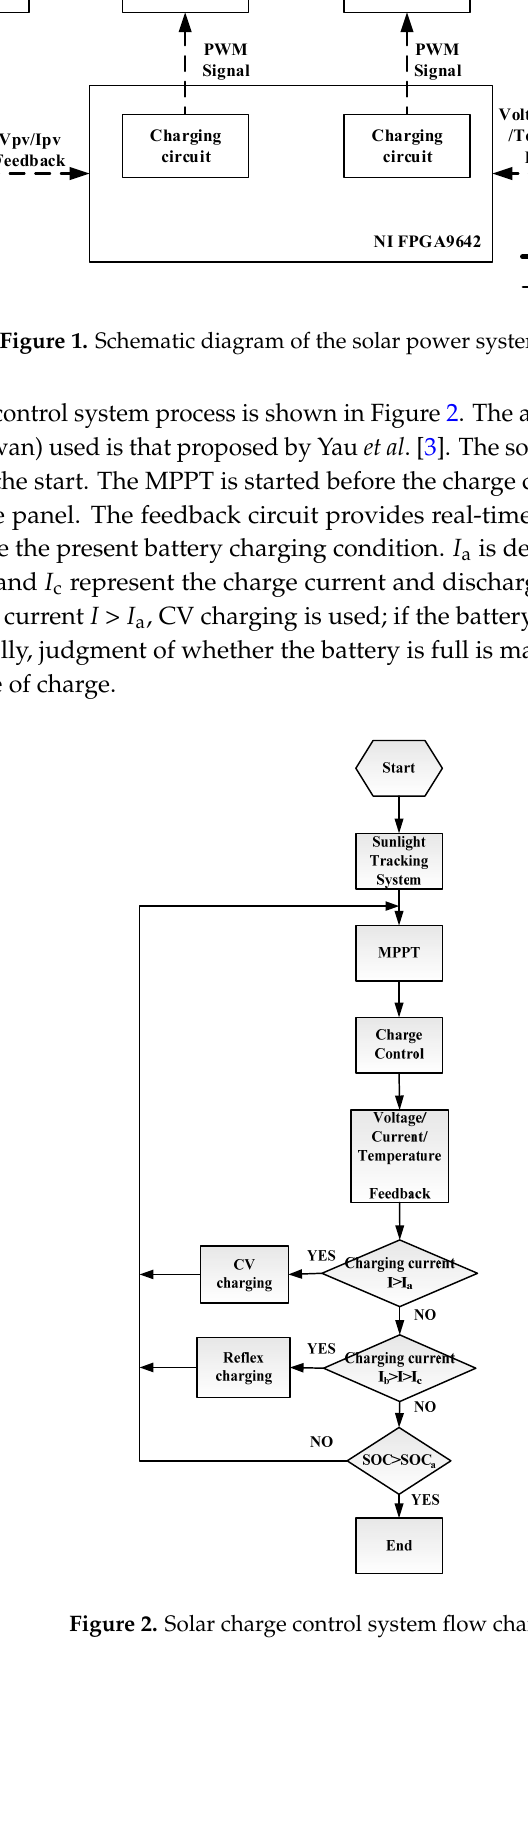
Figure 2. Solar charge control system flow chart.